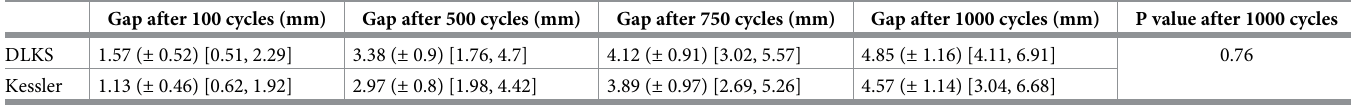
Table 1. Mean displacement during cyclic loading (standard deviation) [minimum, maximum].